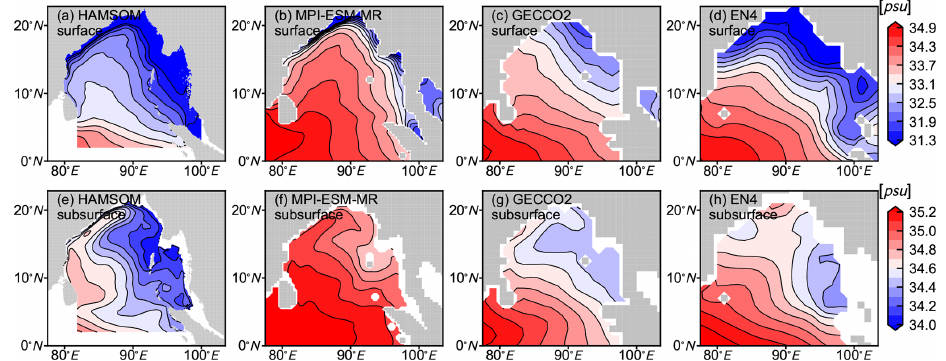
Figure 2. Spatial pattern of climatological surface (a, b, c, d) and subsurface (100m; e, f, g, h ) salinity from HAMSOM, MPI-ESM-MR, GECCO2, and EN4, respectively. The contour intervals are 0.3psu for the surface but 0.1psu for the subsurface.